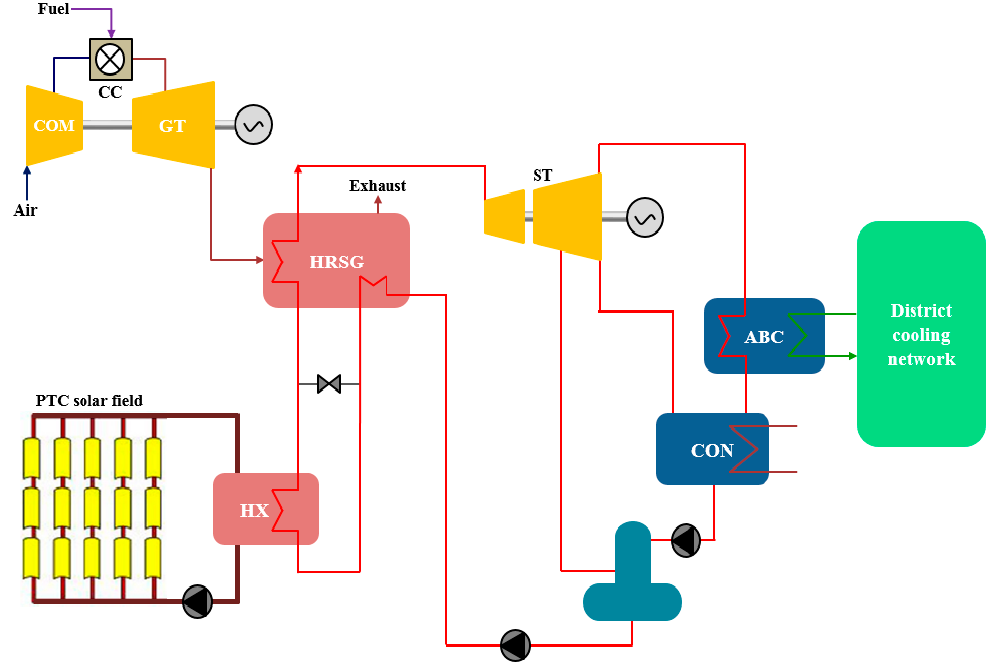
Figure 6. Solar combined cooling and power (SCCP) plant proposed by Perdichizzi et al., adapted